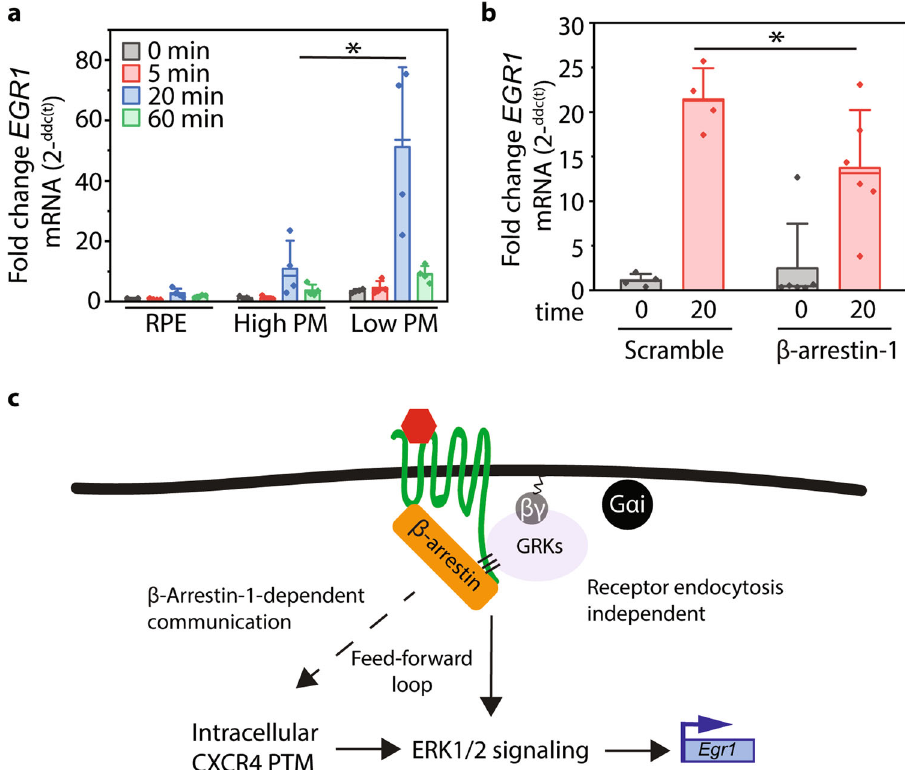
Fig. 5 Intracellular pools of CXCR4 are primarily responsible for EGR1 transcription. a qPCR analysis of EGR1 transcription in WT RPE or RPE cells overexpressing high or low plasma membrane-localized WT CXCR4. EGR1 transcript levels were calculated using the ΔΔ CT method normalized to